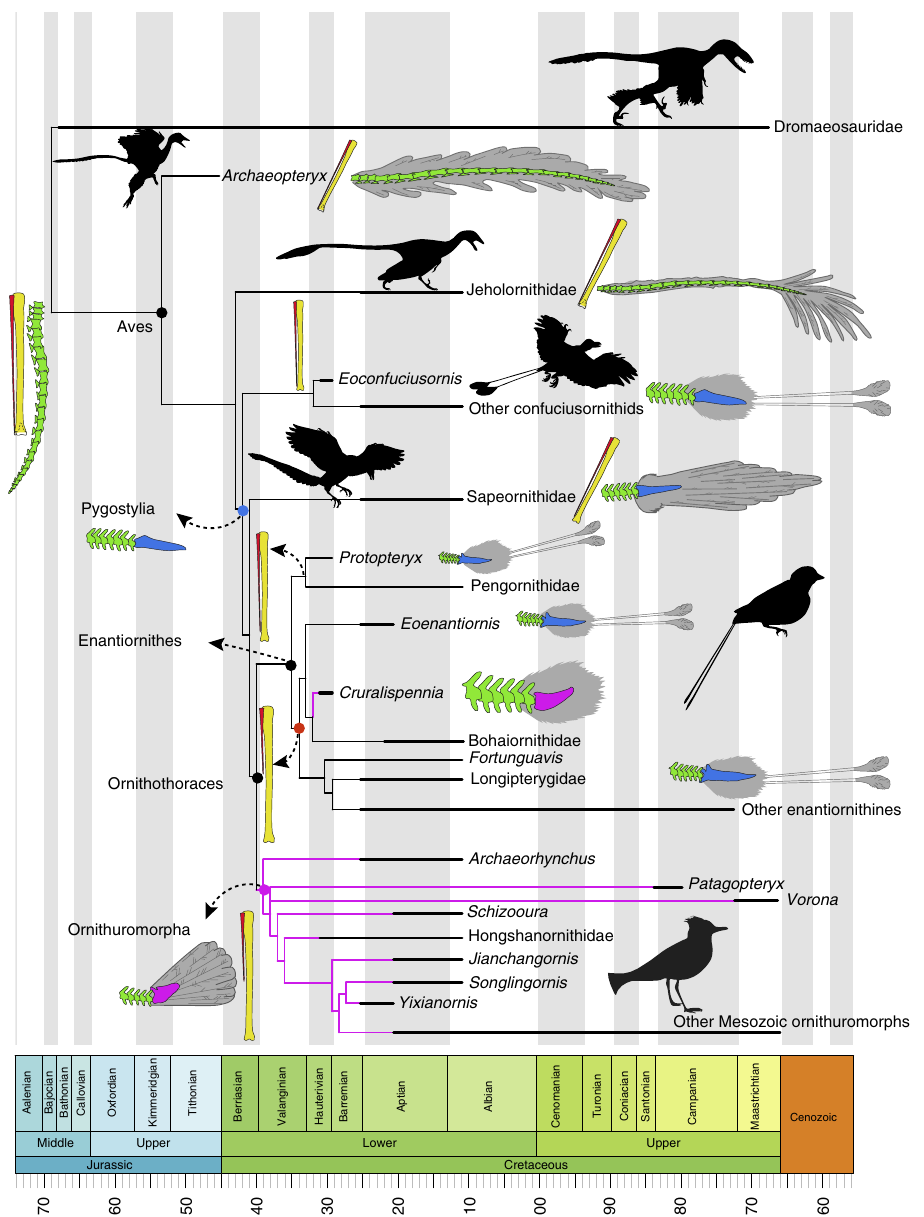
Figure 7 | Major transitions of fibula and tail morphology across Mesozoic birds. The tree, simplified from the strict consensus tree produced by our phylogenetic analysis, is time-scaled using the ‘minimal branch length’ method with a minimum branch length of 1Myr (see Supplementary Fig. 5 for complete result and node support values). The thick lines indicate the temporal range of fossil taxa. An elongated fibula (in red) is developed in non-ornithothoracine Aves, and the most basal enantiornithines Protopteryx and Pengornithidae; a reduced fibula is convergently evolved in the Ornithuromorpha and derived enantiornithines. Cruralispennia preserves a plough-shaped pygostyle (in pink), which has long been considered unique to Ornithuromorpha (the pink branches). The apparent absence of tail fanning in Cruralispennia indicates that the plough-shaped pygostyle and tail fanning is evolutionarily decoupled in this lineage (the silhouettes were from ref. 47; the reconstruction of tail feathers is on basis of refs